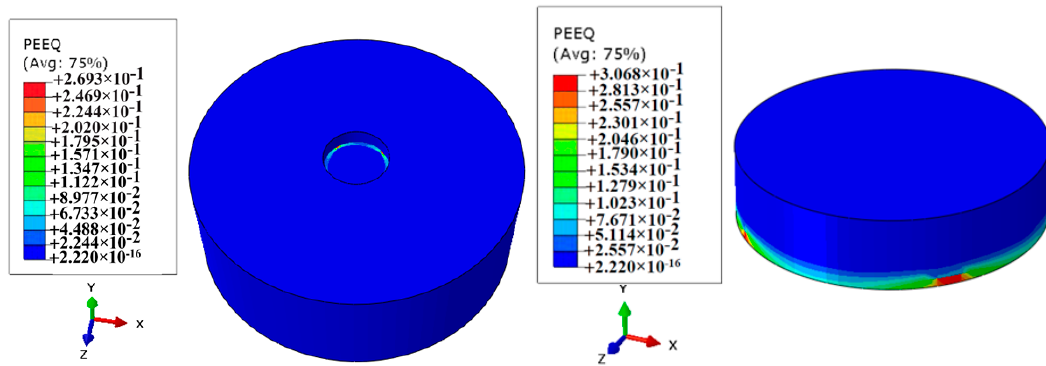
Figure 7. Damage done by plastic in the soil.